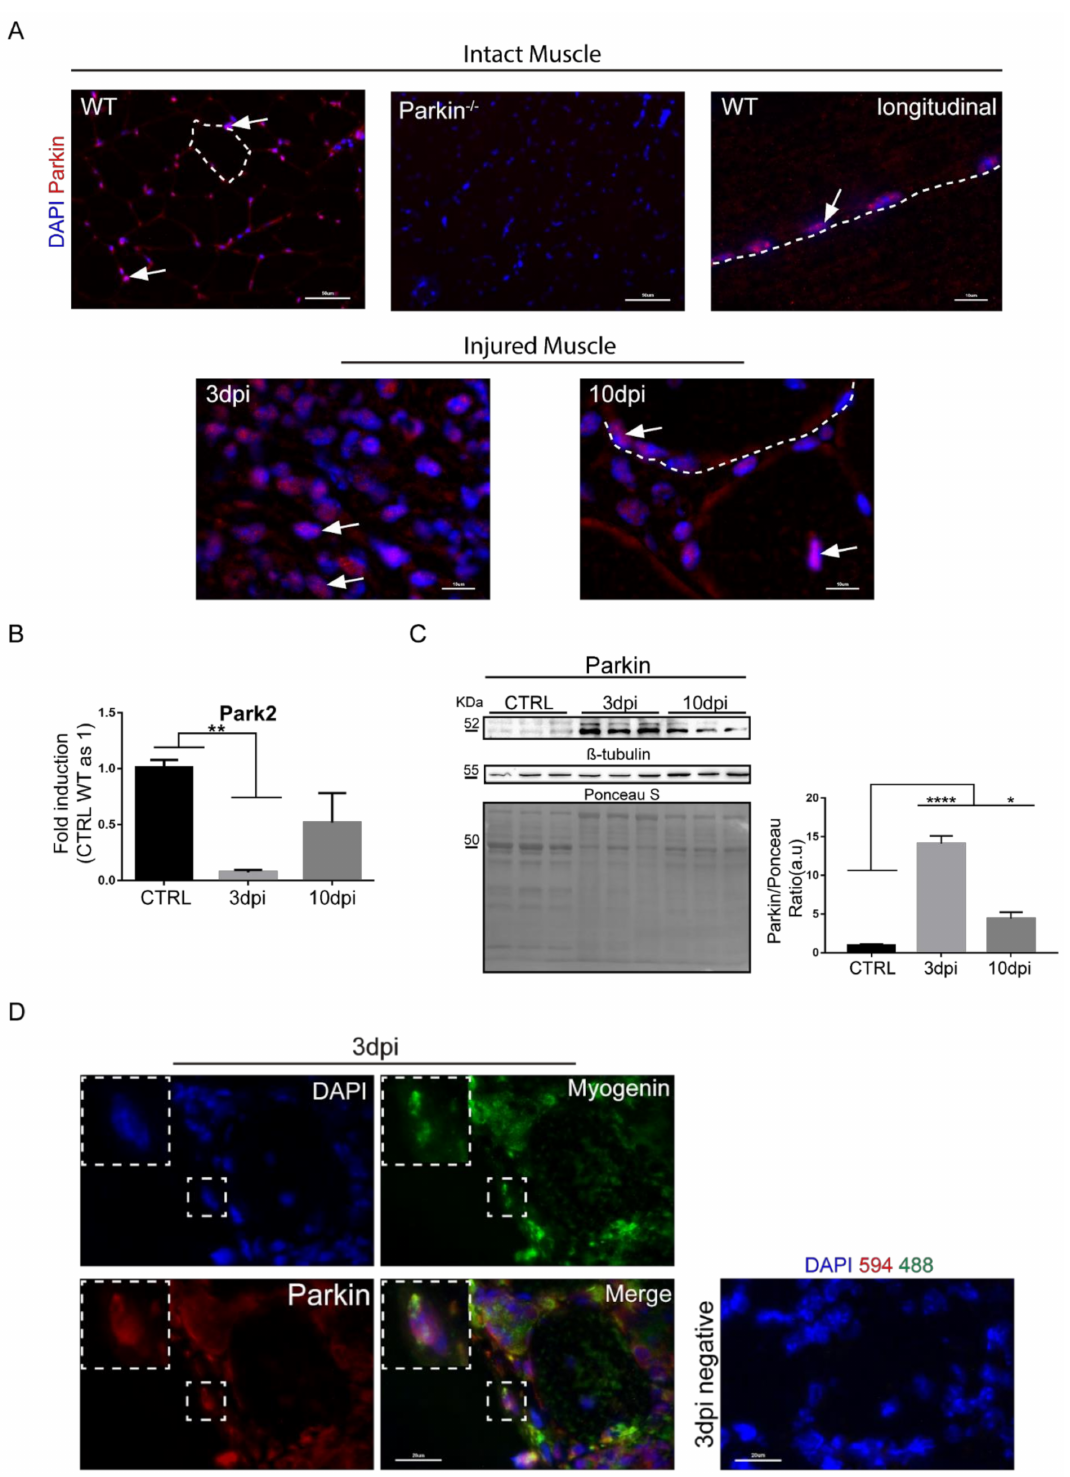
Figure 1. Parkin expression and localization during muscle regeneration. ( A ) Immunofluorescence staining for Parkin (red) and nuclei (blue) in the intact and injured TA muscle from WT mice in CTRL and at 3 and 10 dpi. The intact muscle of Parkin – / – mice was used to confirm the specificity of the antibody staining. The arrows indicate Parkin’s location near the nuclei and the dotted areas delineate myofibers. The images were acquired with 40 × and 100 × objectives. Arrows indicate the location of Parkin near the nuclei. The myofibers are marked by dotted area. Bars in upper panel represent 50 µ m; bars in lower panel represent 10 µ m. ( B ) Park2 relative mRNA expression (RT-PCR) in TA muscle